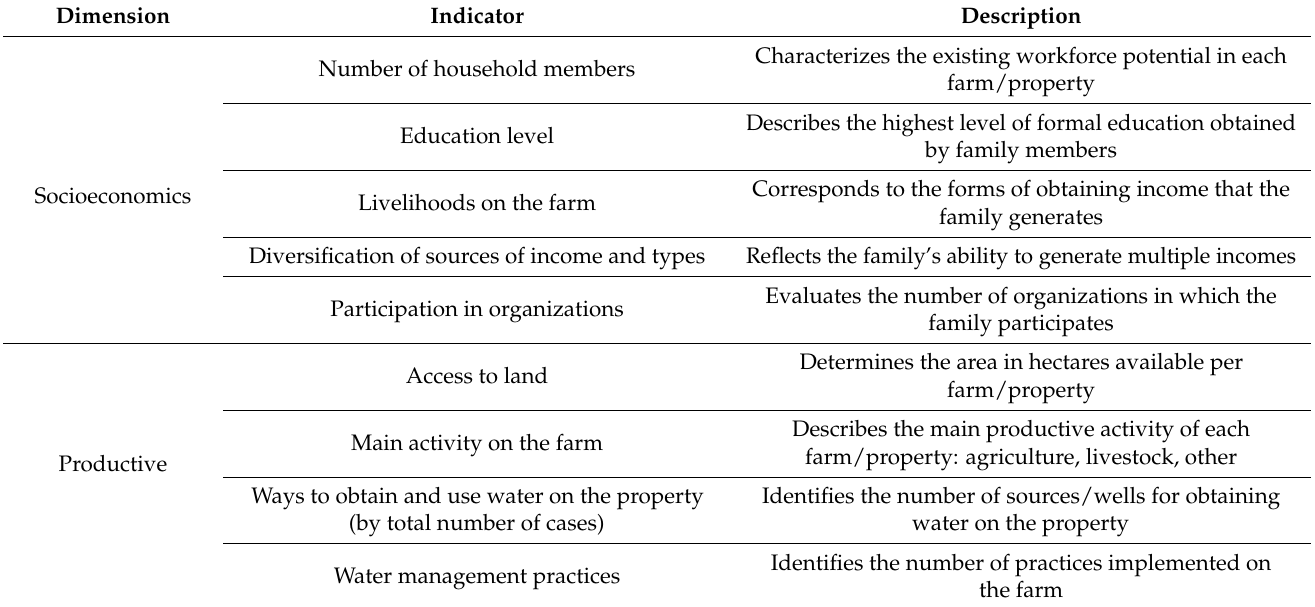
Table 1. Description of parameters used to describe family farmer communities (modified from Paz and Ortega [25]).